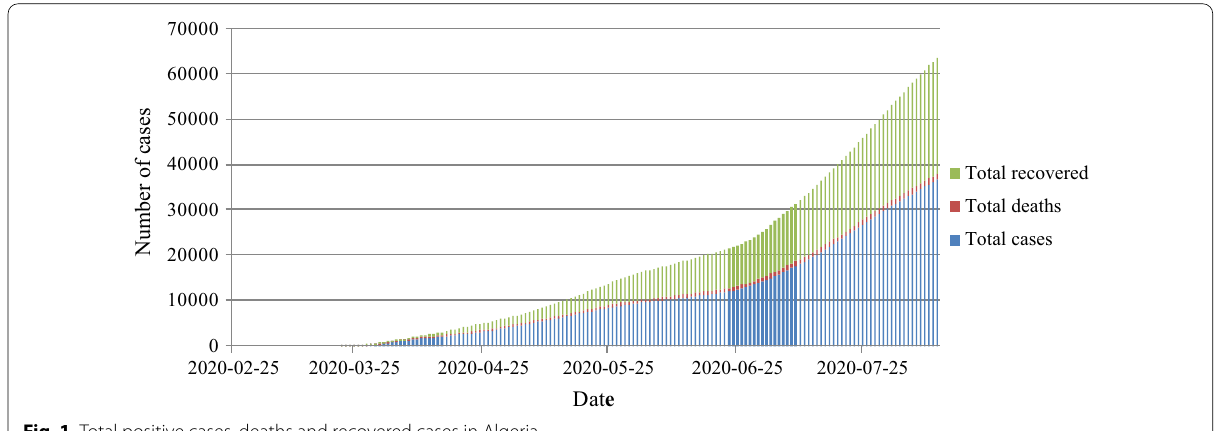
Fig. 1 Total positive cases, deaths and recovered cases in Algeria